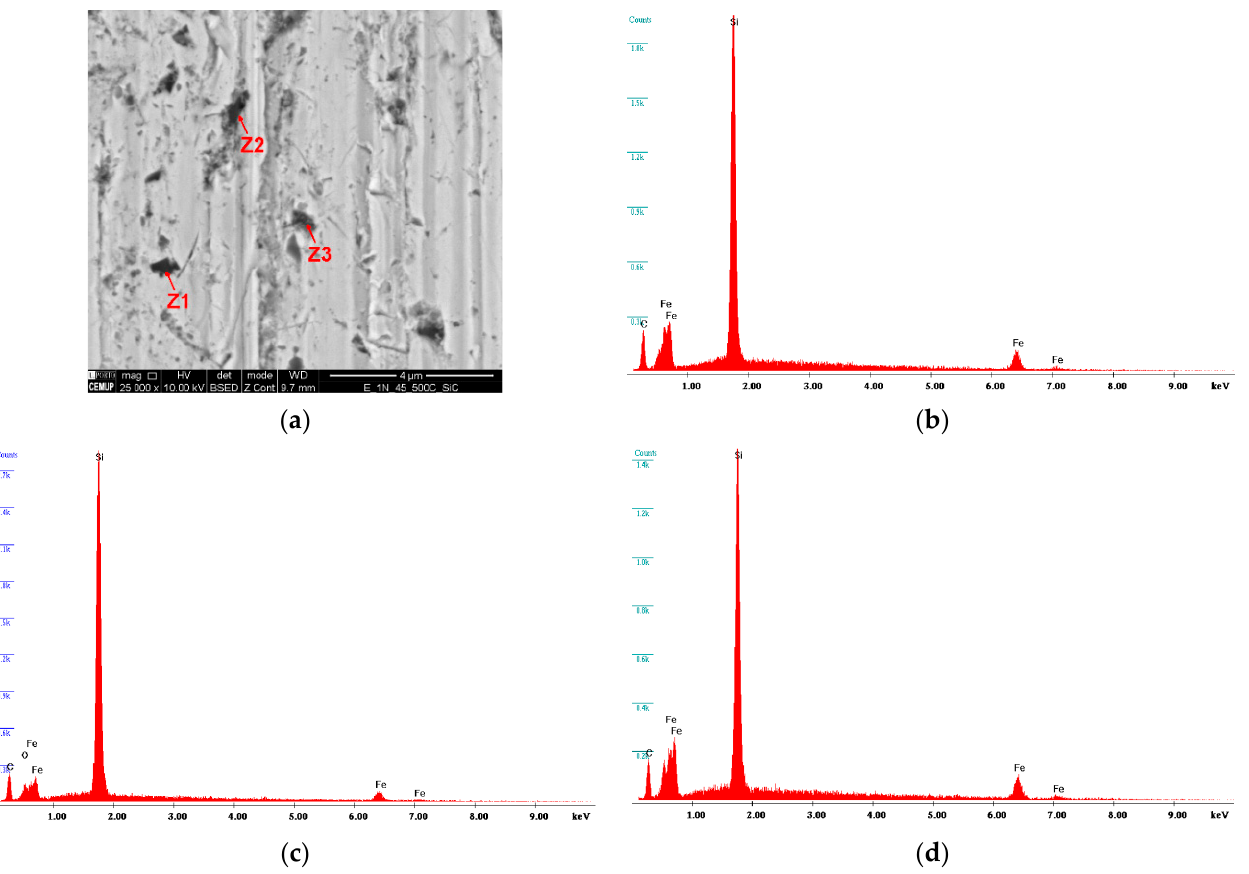
Figure 16. Analysis of aggregation of abrasive particles in the center of the rail for SC 0.45 g/cm 3 with normal load of 1 N: ( a ) SEM analysis in the inside of the trail; ( b ) EDS spectrum in the Z1 zone indicating SiC Particle; ( c ) EDS spectrum in the Z2 zone indicating SiC Particle; and ( d ) EDS spectrum in the Z3 zone, indicating SiC Particle.